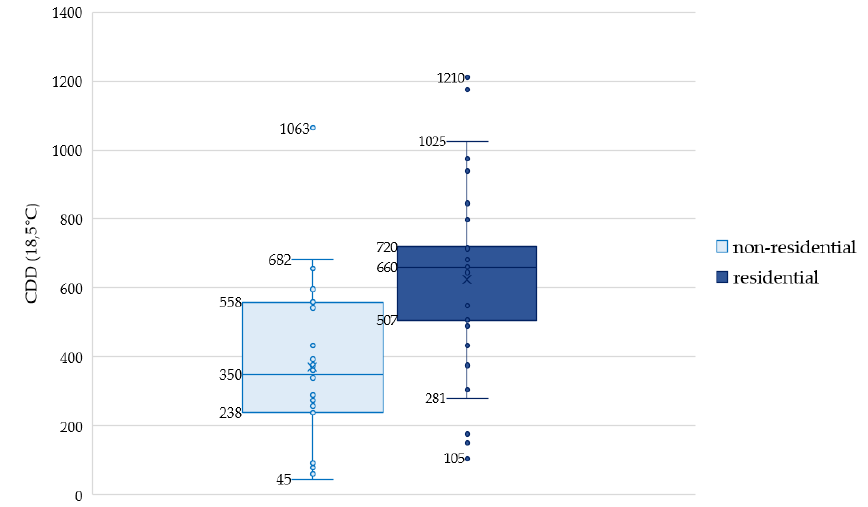
Figure 20. Distribution of CDD of residential and non ‐ residential buildings with cooling systems. In 75% of the residential buildings collected, the CDD results are equal to or higher than 510 CDD, while, in the non ‐ residential buildings, results are equal to or higher than 240 CDD.